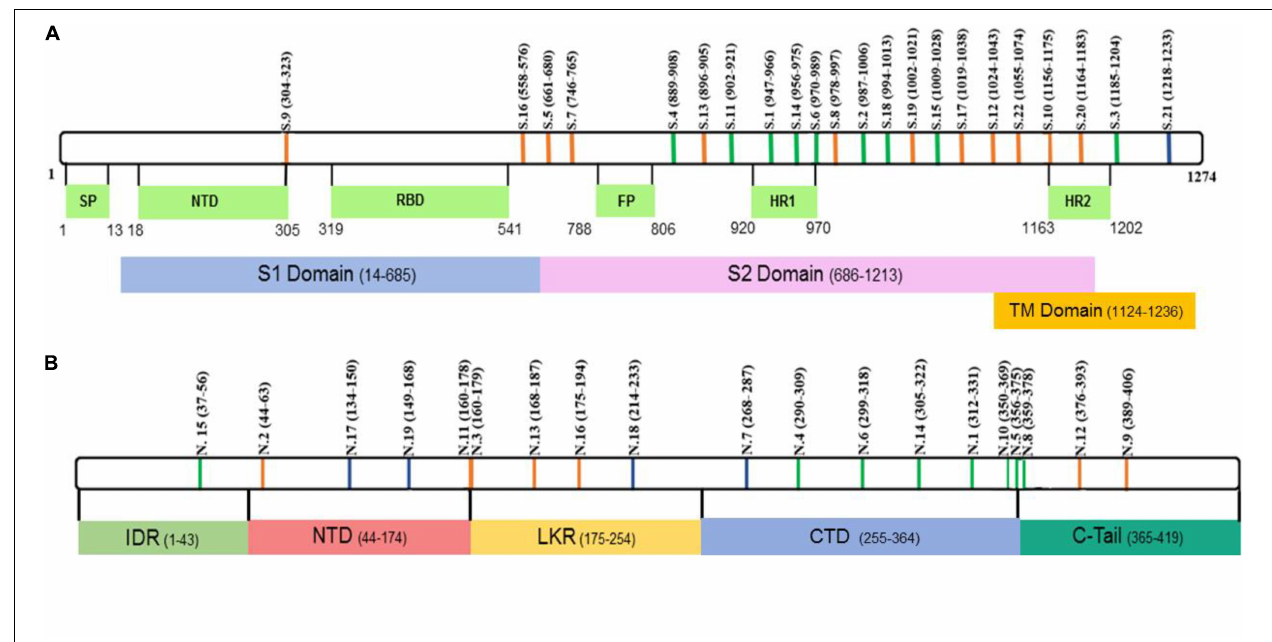
FIGURE 1 | Schematic presentation of SARS-CoV-2 (A) S and (B) N peptide locations. Green – peptides containing both, B and T cell, epitopes. Blue – peptides containing only T cell epitopes. Orange – peptides containing only B cell